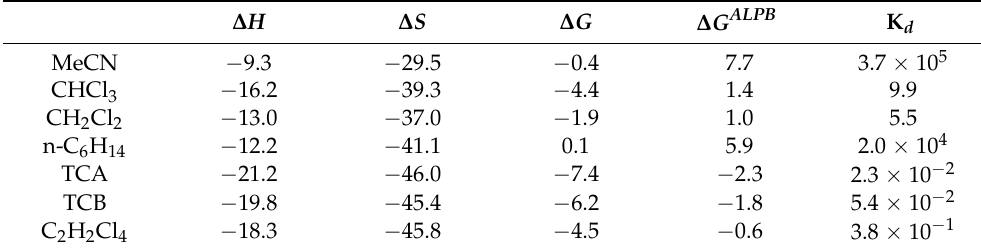
Table 7. Enthalpies (kcal/mol), entropies (cal/[K.mol]) and Gibbs free energies (kcal/mol) for the formation of complexes between the buckycatcher and several solvents at 300 K. Dissociation constants (K d ) calculated in solution. ∆ H ∆ S ∆ G ∆ G